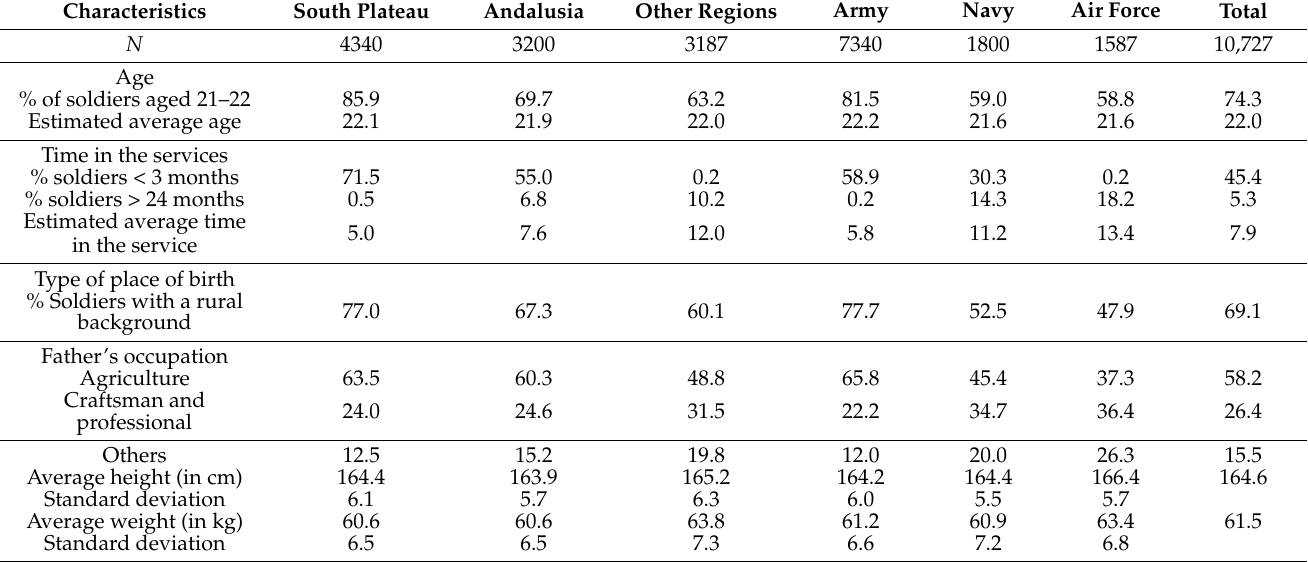
Table 5. Characteristics of the soldiers taking part in the survey by region and armed forces branch.